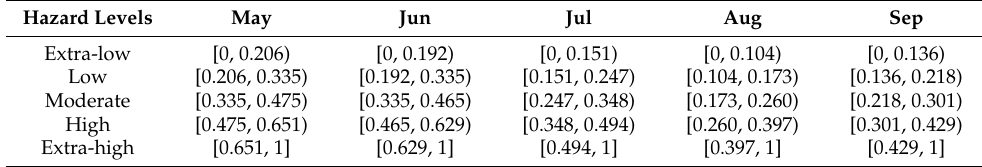
Table 3. Agricultural drought hazard level thresholds for the growing season of crops in NEC.